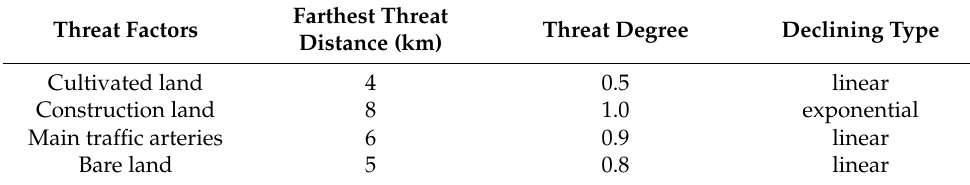
Table 1. Habitat threat factors and threat degree.